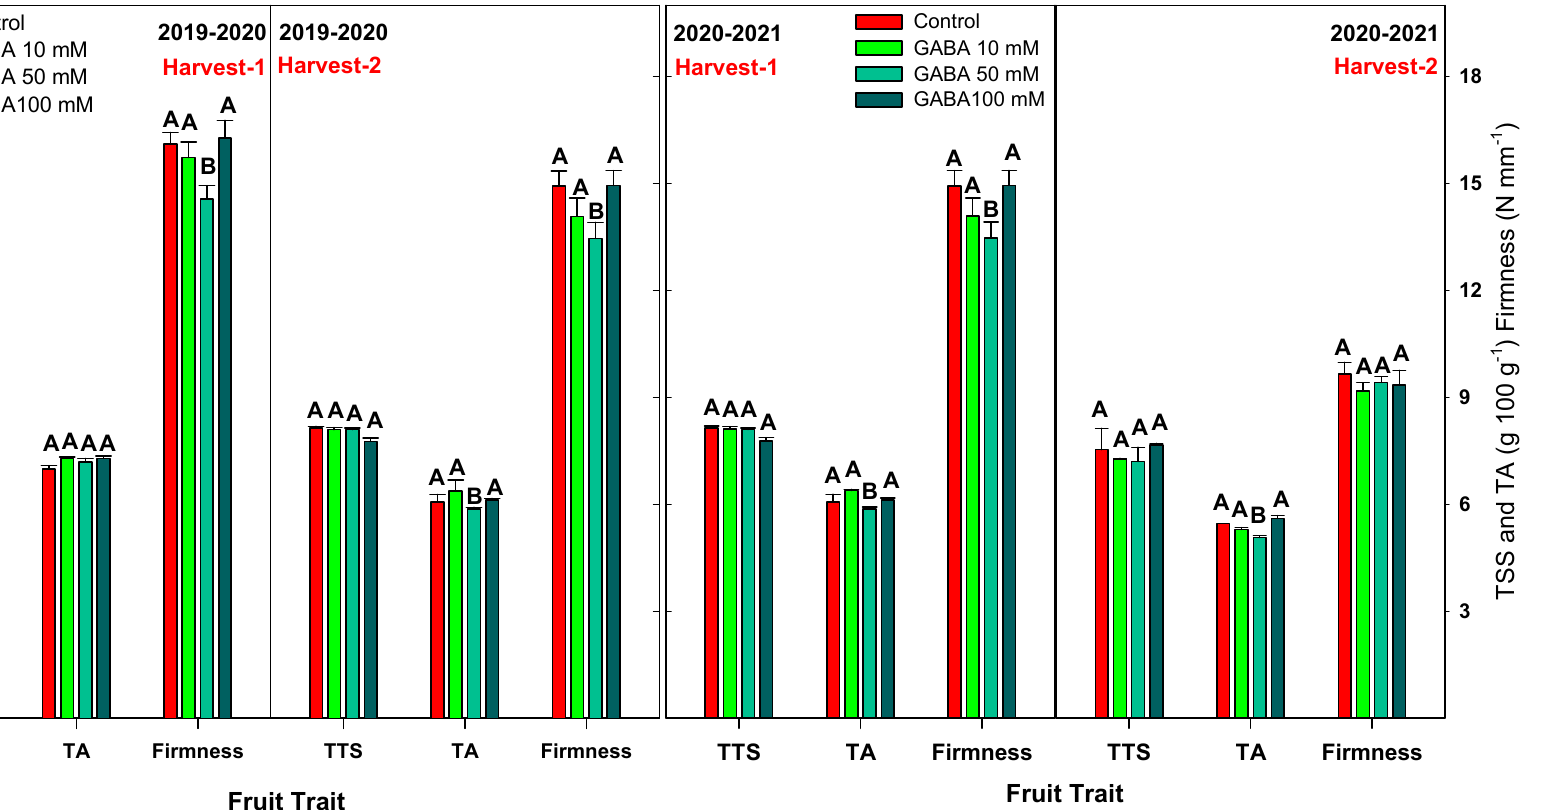
Figure 6. Quality traits of lemons for the two harvest dates and two seasons as affected by GABA treatment. Data are the mean ± SE. Different letters (A and B) on the bars denote significant differences at p < 0.05 among treatments for each quality parameter.